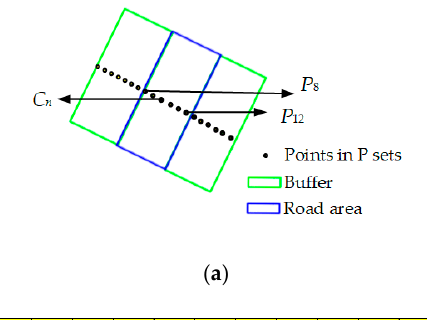
Figure 8. Local texture self-similarity analysis.